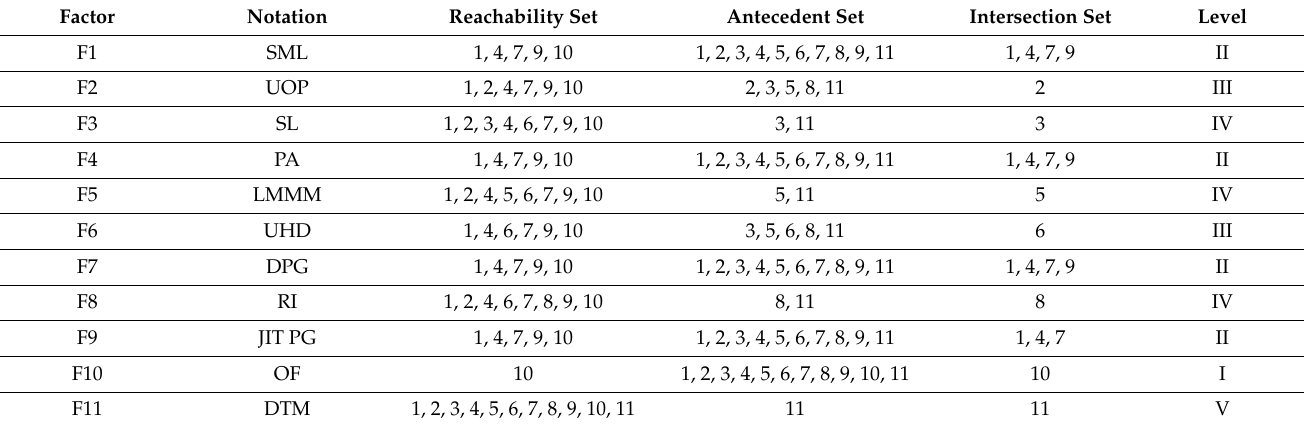
Table 4. Level-partition table.